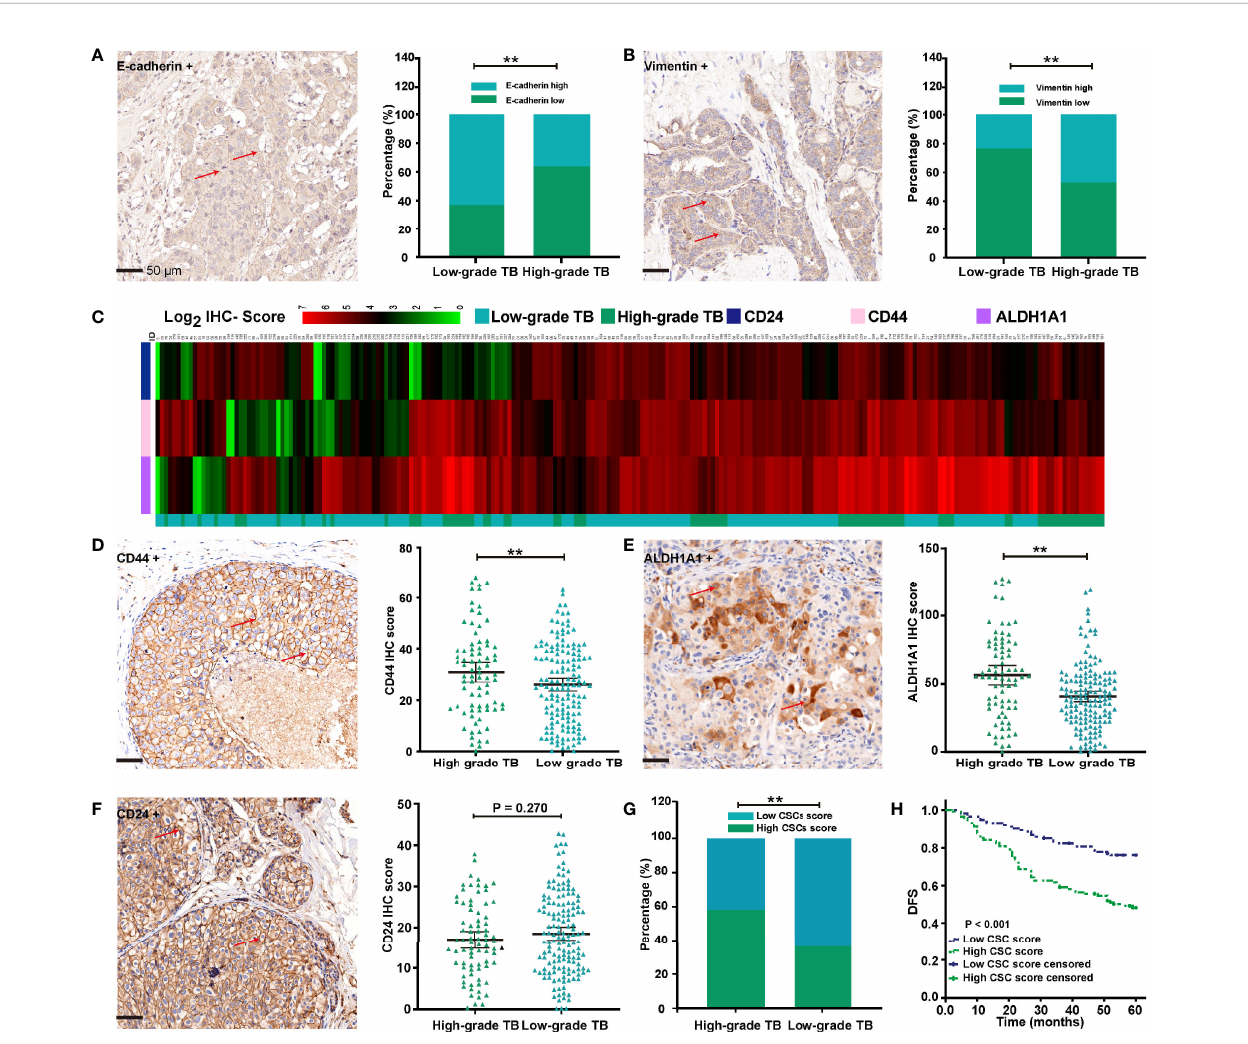
FIGURE 3 | Associations of TB with EMT and tumor stemness. (A) Representative IHC images of E-cadherin and its associations with TB grade. (B) Representative IHC images of vimentin and its associations with TB grade. (C) Heatmap showed CSC marker expression in 229 cases of BC patients. (D) Representative IHC images of CD44 and its associations with TB grade. (E) Representative IHC images of ALDH1A1 and its associations with TB grade. (F) Representative IHC images of CD24 and its associations with TB grade. (G) Association between TB grade and CSC score. (H) The Kaplan-Meier survival curve shows disease-free survival of BC after strati fi cation by CSC score. ** p <